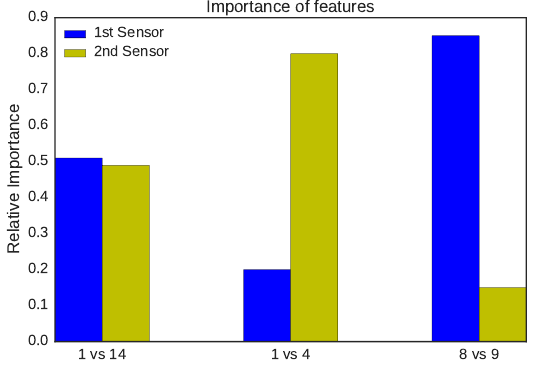
Figure 6. Feature importance of three tested